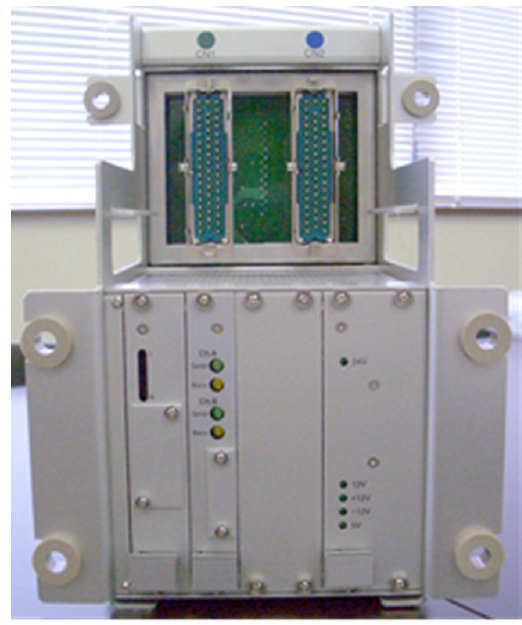
Figure 10. Control unit for the Bogie Abnormal Swing Detection System.